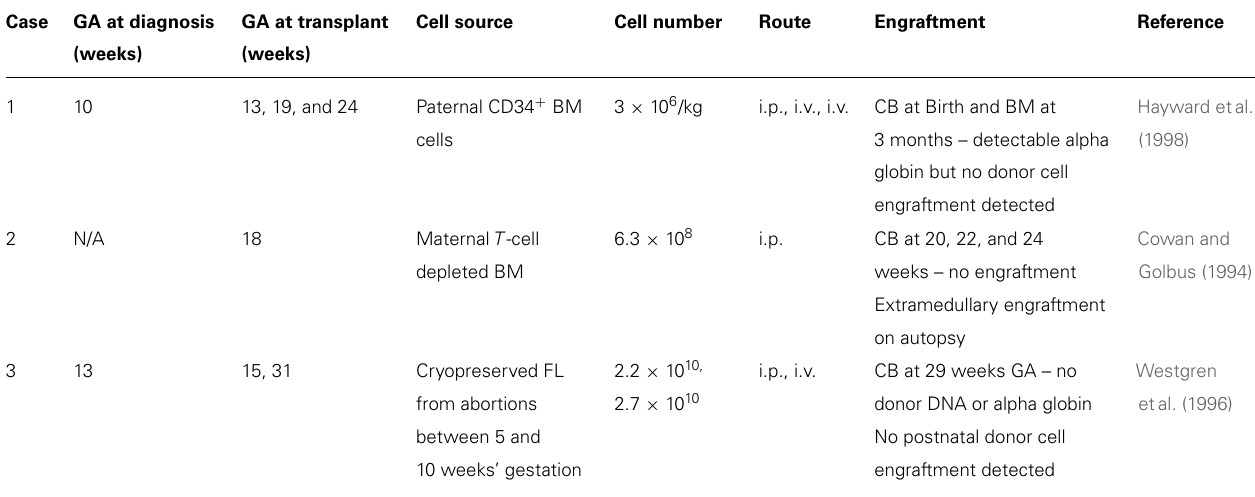
Table 1 | In utero transplantation for